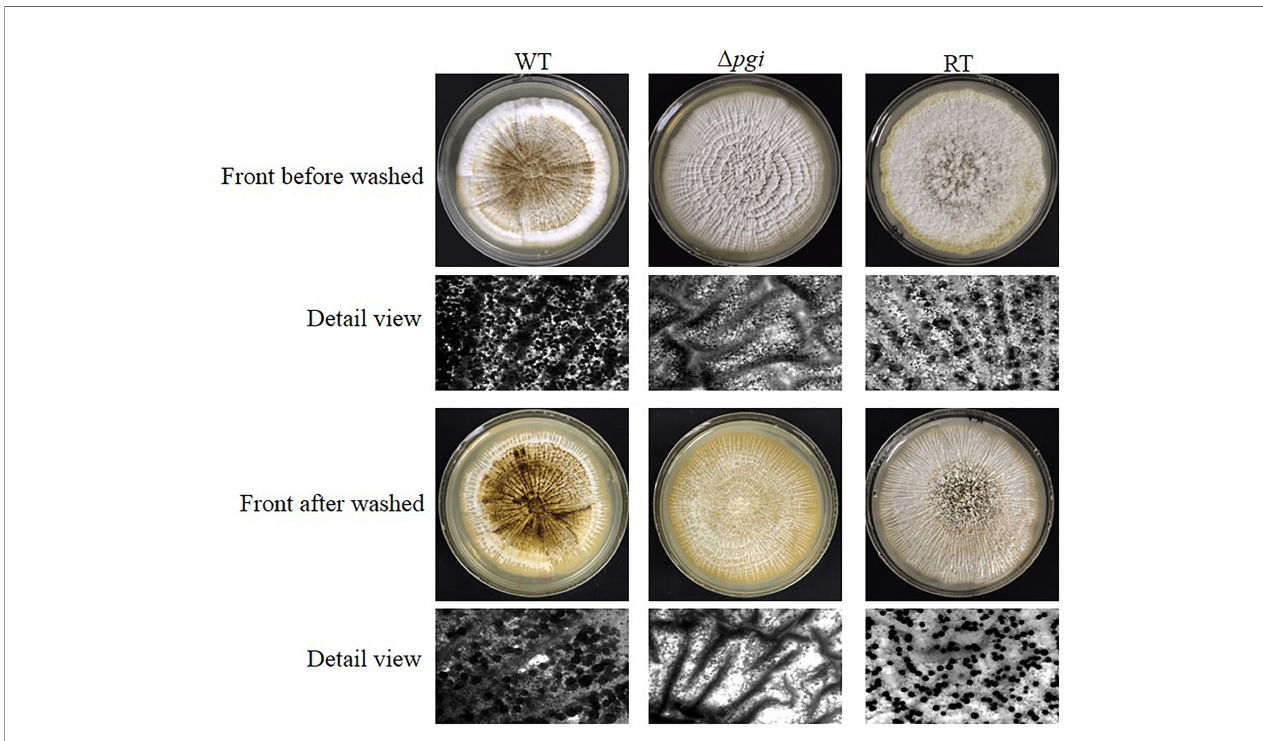
FIGURE 4 | Sclerotium formation of the D pgi mutant under MMFG cultivation. 10 5 conidia of the WT, D pgi , and RT strains were inoculated onto MMFG plates and incubated in the dark at 37°C for 7 days. A stereomicroscope was used for taking